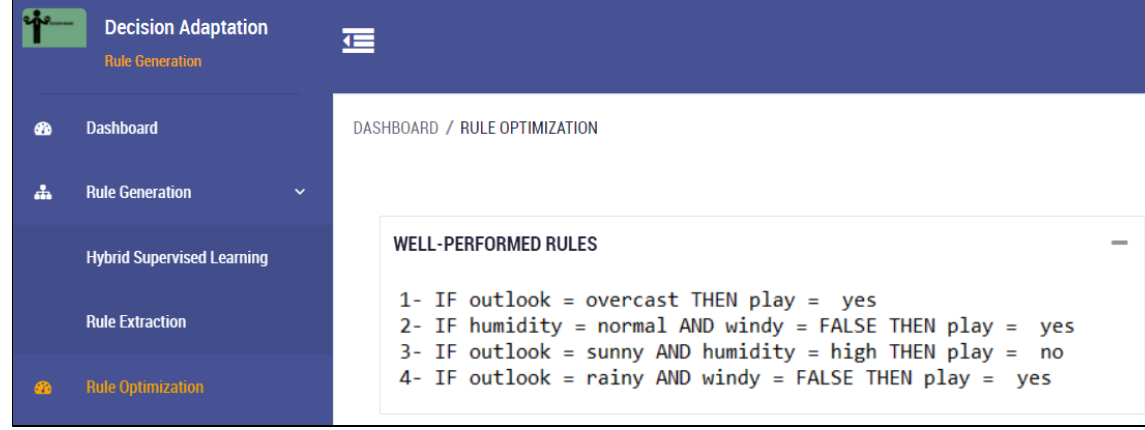
Figure 9. An excerpt of the well-performed